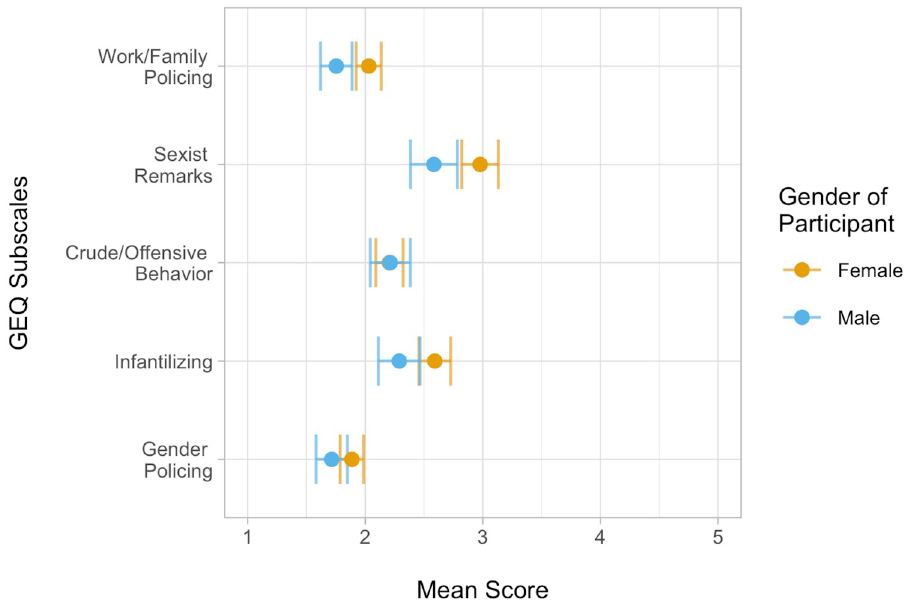
Fig 1. Mean GEQ subscale scores by gender of participant (N = 535; 363 women, 168 men) with standard error bars. Due to small cell size ( n = 3), we excluded non-binary participants from this figure. Figure created using R packages ggplot2 (Version 3.1.0) and colorblindr (Version 0.1.0) [27,